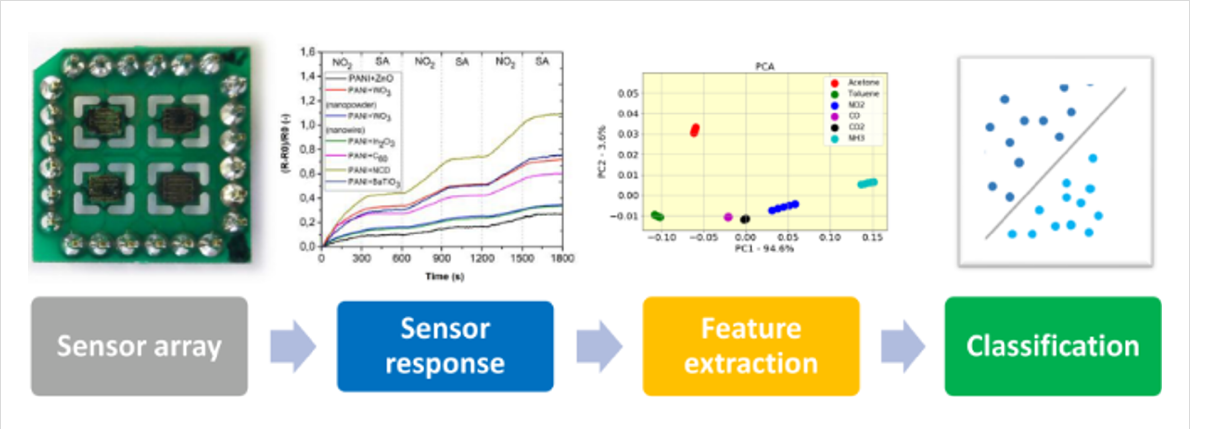
Figure 15: Smart sensing system block diagram.